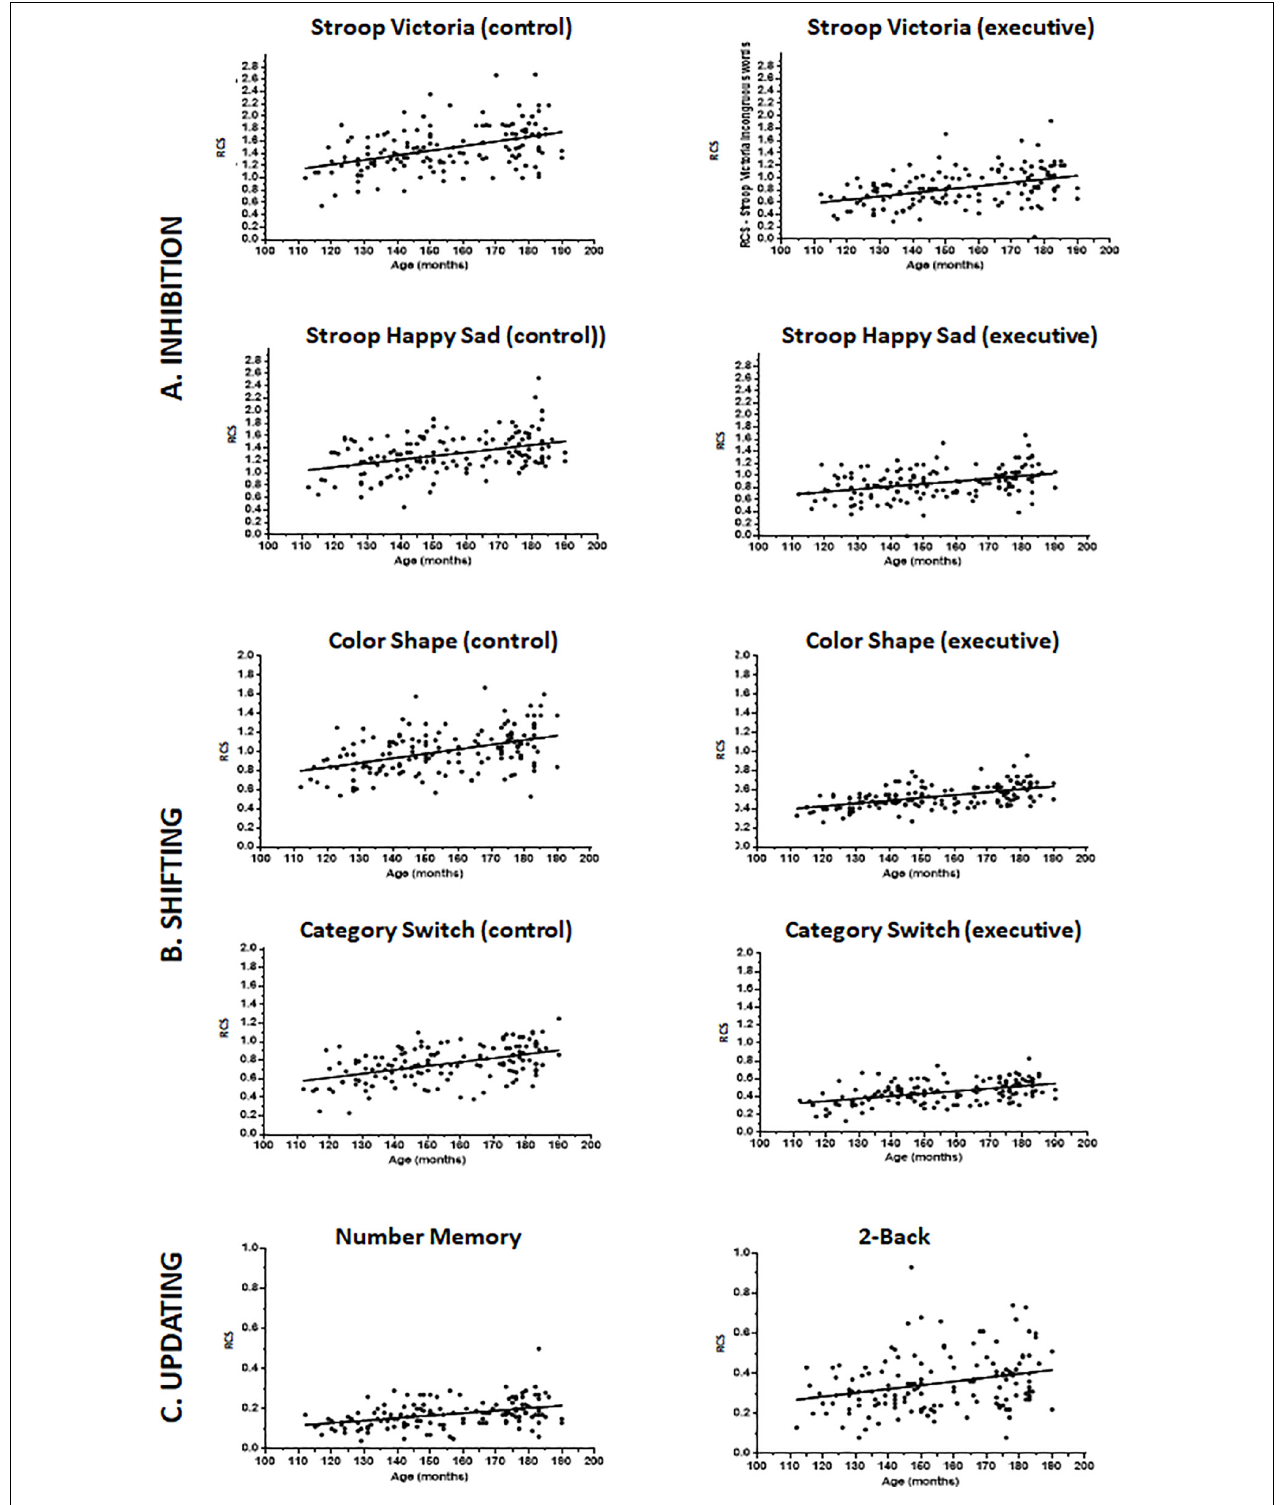
FIGURE 3 | Scatterplot trajectory illustrating Rate Correct Scores (RCS) values per age (months) in the inhibition (A) , shifting (B) , and updating (C) tasks. For inhibition and shifting tasks, scores in the control blocks are on the left, in the executive blocks in the middle and the absolute executive costs are on the far right. Only total scores are represented in the graphs for updating tasks as they do not include control conditions. The regressed line illustrates the association of performance with age, with no correction for socioeconomic status or sex.